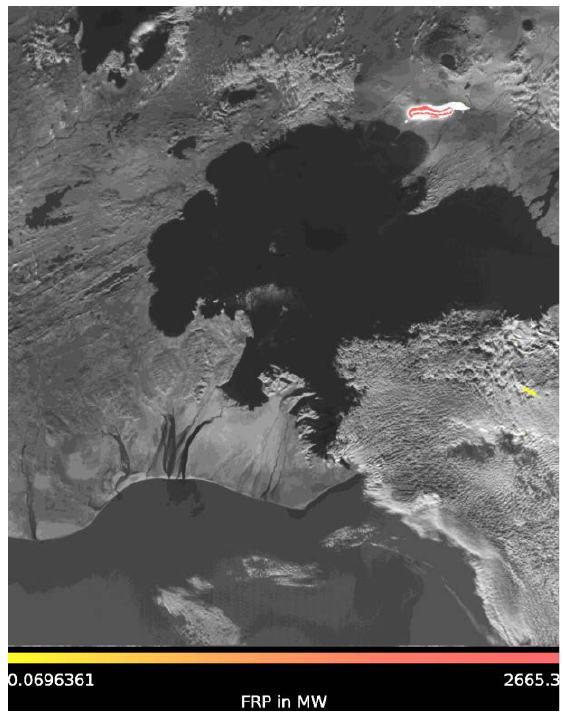
Figure 6. Fire and Ice- The Bardabunga Volcano in